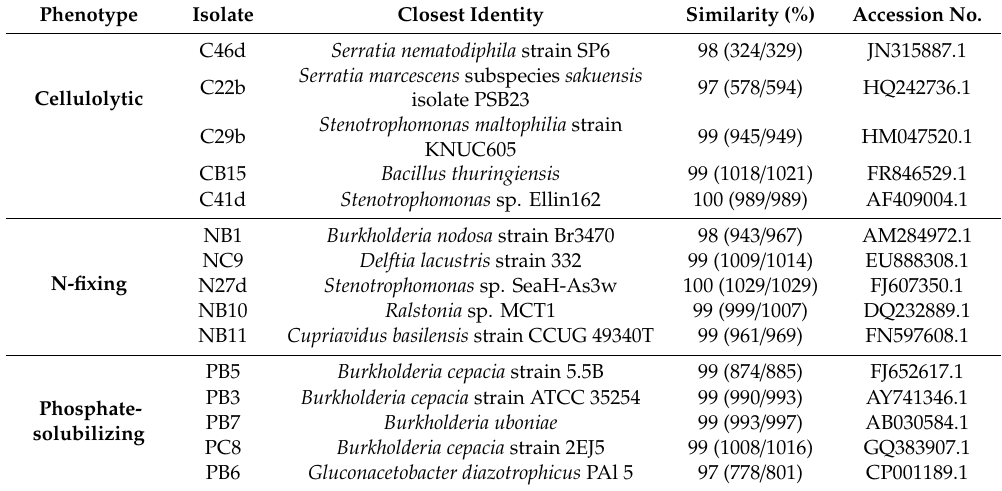
Table 4. Identities of cellulolytic, nitrogen-fixing, phosphate-solubilizing bacterial isolates based on 16S rDNA analysis and the BLAST